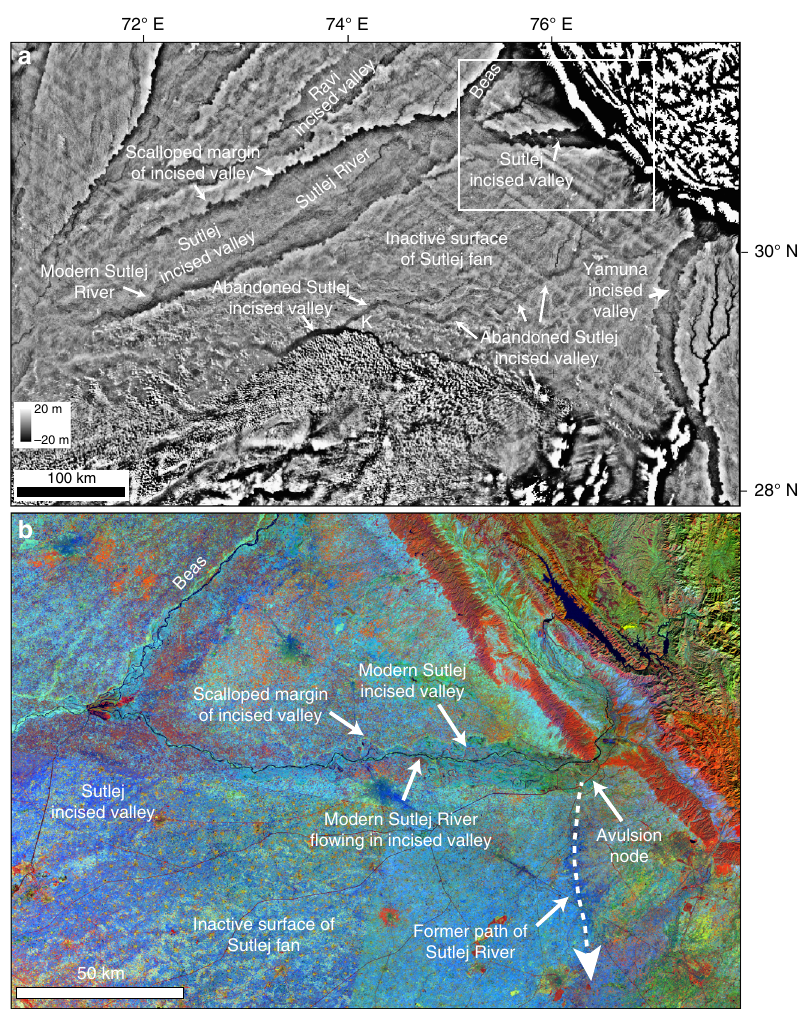
Fig. 10 Topography of Sutlej – Yamuna plains showing modern Himalayan rivers occupy incised valleys. a Detrended relative elevation map, derived from SRTM 30 m DEM (2014 release), showing courses of the modern Sutlej, Beas and Yamuna rivers con fi ned to regionally extensive incised valleys eroded into alluvial deposits of the Indo – Gangetic basin. Con fi nement prevents the rivers from readily avulsing across older fl uvial fan surfaces. White box indicates area of detailed image in b . b Detail from Landsat 5 TM colour composite mosaic in Fig. 2 showing modern Sutlej incised valley near its outlet at Himalayan mountain front. Inferred palaeo-Sutlej course that joins Ghaggar – Hakra palaeochannel, a former Sutlej incised valley, is indicated, as is the